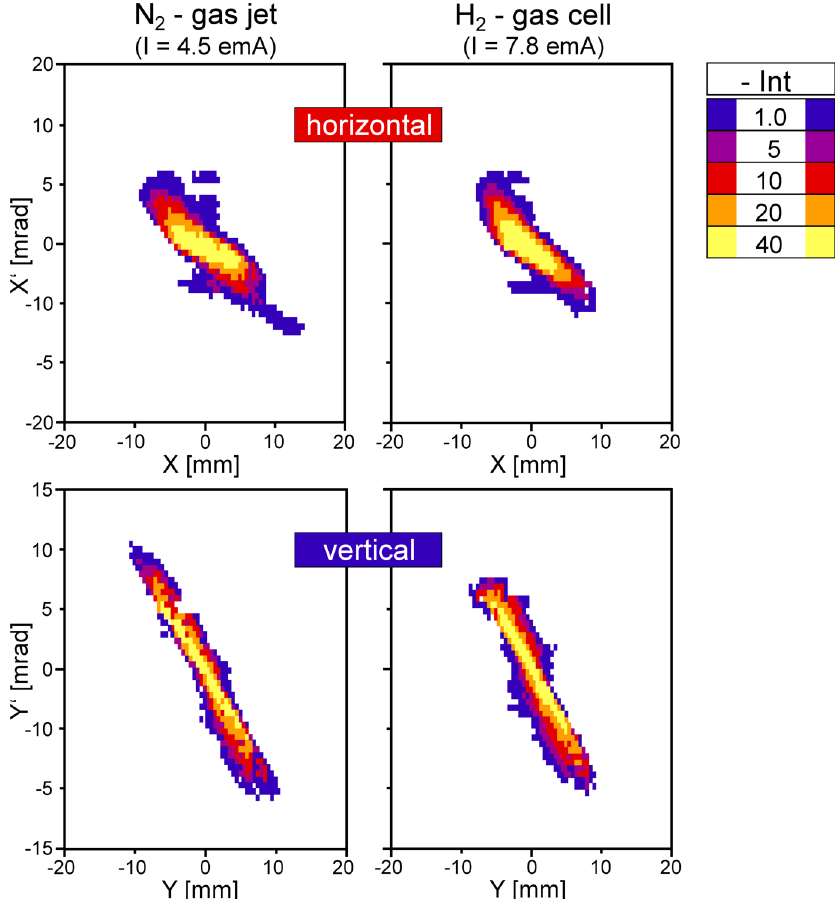
FIG. 8. Measured uranium beam emittance behind N 2 -gas jet (left) and H 2 -gas cell (right) for maximum available back